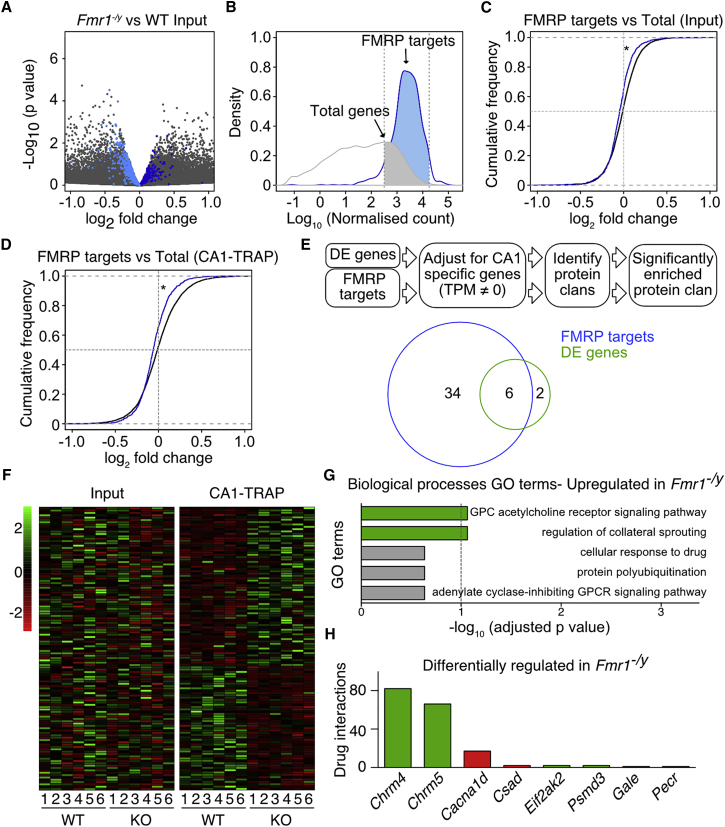
Differentially Translated mRNAs in Fmr1−/y CA1 Include FMRP Targets and mAChR Transcripts(A) Differential expression analysis shows gene changes in WT versus Fmr1−/y Input fraction, with FMRP targets highlighted in blue.(B) FMRP targets were compared to differentially expressed (total) genes with the same level of abundance (normalized count between 102.5 and 104.25).(C and D) A cumulative distribution of FMRP targets shows a significant shift toward downregulation when compared to the distribution of total differentially expressed genes with the same level of abundance in both Input (C) and CA1-TRAP (D) fractions (K-S test, p = 9.23 × 10−14, p = 4.86 × 10−13).(E) Pfam analysis of enriched protein families reveals that six out of eight pClans enriched in the differentially expressed (DE) Fmr1−/y CA1-TRAP gene list overlap with pClans enriched in the CA1-adjusted FMRP target list.(F) Heatmap shows the fold change of differentially expressed genes in each pair of Fmr1−/y versus WT (IP and Input fractions).(G) GO analysis identifies G-protein-coupled acetylcholine receptor signaling pathway as the most enriched functional category in the upregulated Fmr1−/y CA1-TRAP gene list.(H) Drug gene interaction database reveals that Chrm4 is the most amenable target pharmacologically. Upregulated genes are highlighted in green, and downregulated genes are highlighted in red. n = number of littermate pairs. Error bars indicate SEM.